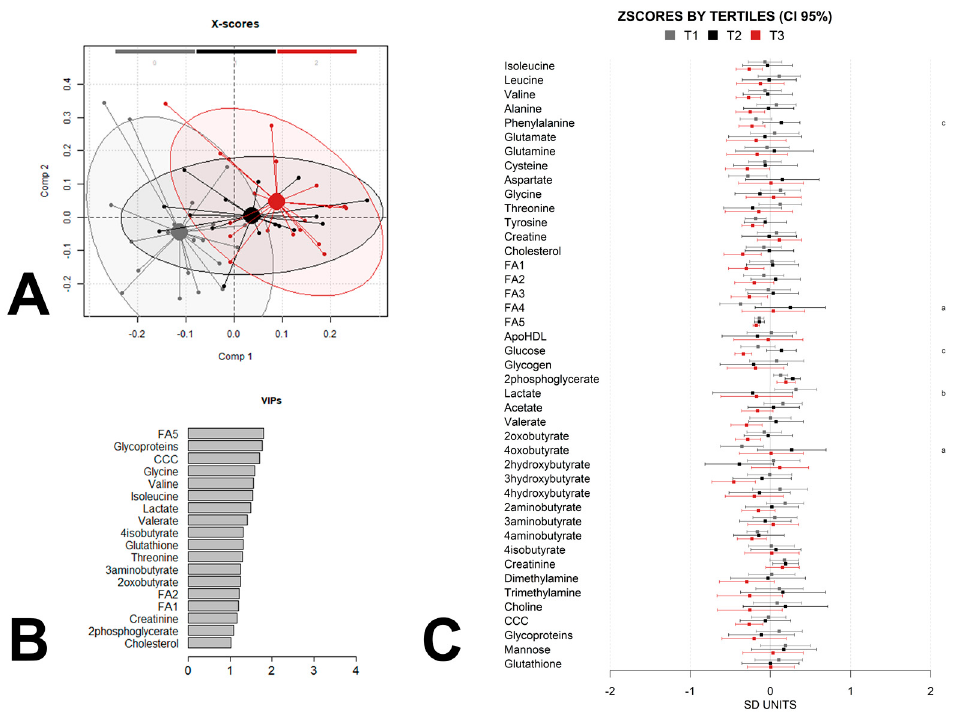
Figure 2. PLSDA analysis and z-scores of newborn metabolome at birth by maternal-weight gain tertile. ( A ) Score plot with 95% confidence ellipse of the PLS-DA analysis of the metabolome, adjusted for child sex, child weight at birth, maternal obesity, maternal diabetes, and maternal adherence to the Mediterranean diet for the discrimination between tertiles (tertile 1(T1) gray, tertile 2 (T2) black, tertile 3 (T3) red). Cross-validation parameters: RMSECV 0.304, R2CV: 0.582; ROC curve AUC: 0.96. ( B ) Metabolites with PLS-DA VIP score higher than 1 for the same PLS-DA metabolome model. ( C ) Z-scores and 95% confidence intervals of individual metabolites in offspring grouped by tertile. Metabolites with statistically significant pairwise differences between tertiles (adjusted p -value < 0.05) are labelled as “a” (tertile 1 vs. tertile2), “b” (tertile 1 vs. tertile 3), and/or “c” (tertile 2 vs. tertile 3). Label keys are the same as those in Figure 1.